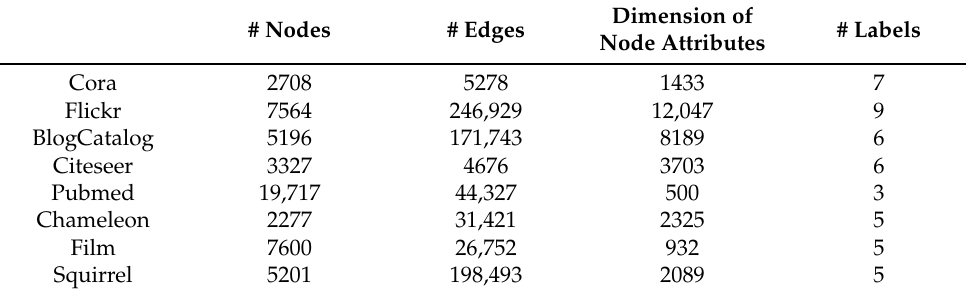
Table 2. Statistics of all real-world datasets used in the experiments. Dimension of # Nodes # Edges # Labels Node Attributes Cora 2708 5278 1433 7 Flickr 7564 246,929 12,047 9 BlogCatalog 5196 171,743 8189 6 3327 3703 6 19,717 44,327 500 3 2277 2325 5 Film 7600 26,752 932 5 Squirrel 5201 198,493 2089